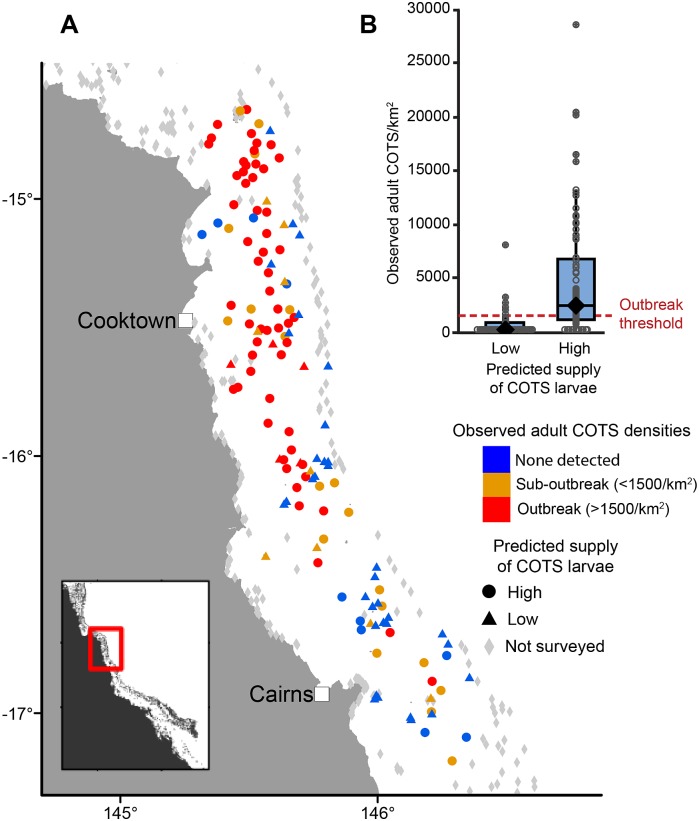
Linking connectivity and COTS abundance estimates from field surveys.(A) A map of the GBR region surveyed for COTS in 2013–2015. Reefs with low predicted supply of COTS larvae (triangles; N = 48) were more likely to have low levels of adult COTS or no adult COTS detected (blue symbols). The highest incidence of COTS outbreaks (red) was observed on reefs with high potential supply of COTS larvae (circles; N = 89). Note that, although the outbreaks originated in the area north of Cooktown and spread southwards, latitude and longitude were not significant predictors in the analysis, but they were kept in the model as covariates to ensure that any spatial pattern observed in the figure did not affect the observed effect of connectivity. (B) Reefs with high predicted supply of COTS larvae had significantly higher densities of adult COTS. The outbreak threshold of 1,500 adult COTS km−2 is shown as a red line [30]. The box plots show medians (black diamonds) and quartiles (blue box). The analysis also included a datum in the high category with an estimated COTS density of >30,000 per km2. Data provided in S1 Data. COTS, crown-of-thorns starfish; GBR, Great Barrier Reef.